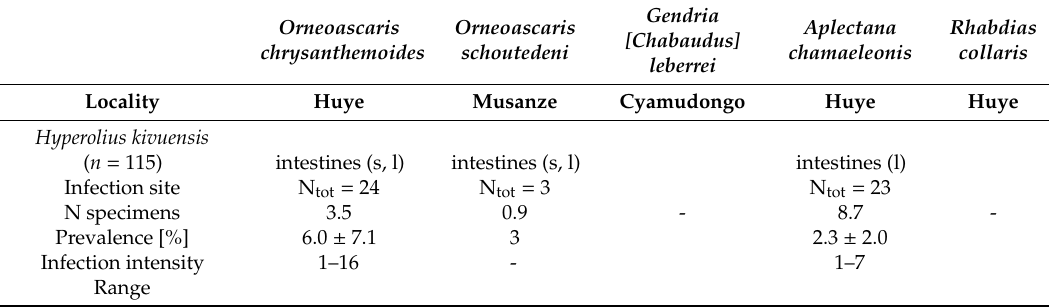
Table 3. Parasitism of reed frogs by nematodes in Rwanda: infection site (s, small; l, large), number of nematodes (N tot ), prevalence (presented as the number of parasitized frog hosts by the total number examined), mean intensity of infection ± SD (as mean number of parasites per individual frog) and range of nematodes